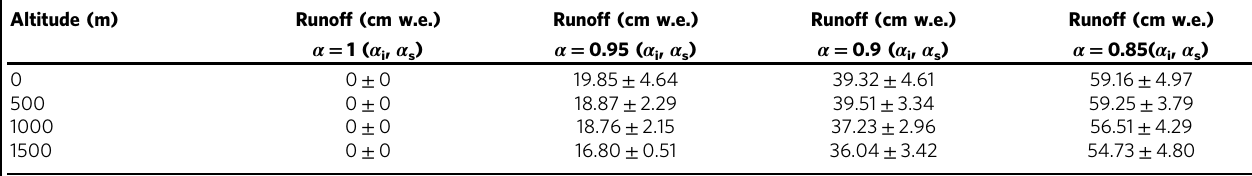
Table 3 Modeled change in runoff in response to ash deposition Altitude (m) Runoff (cm